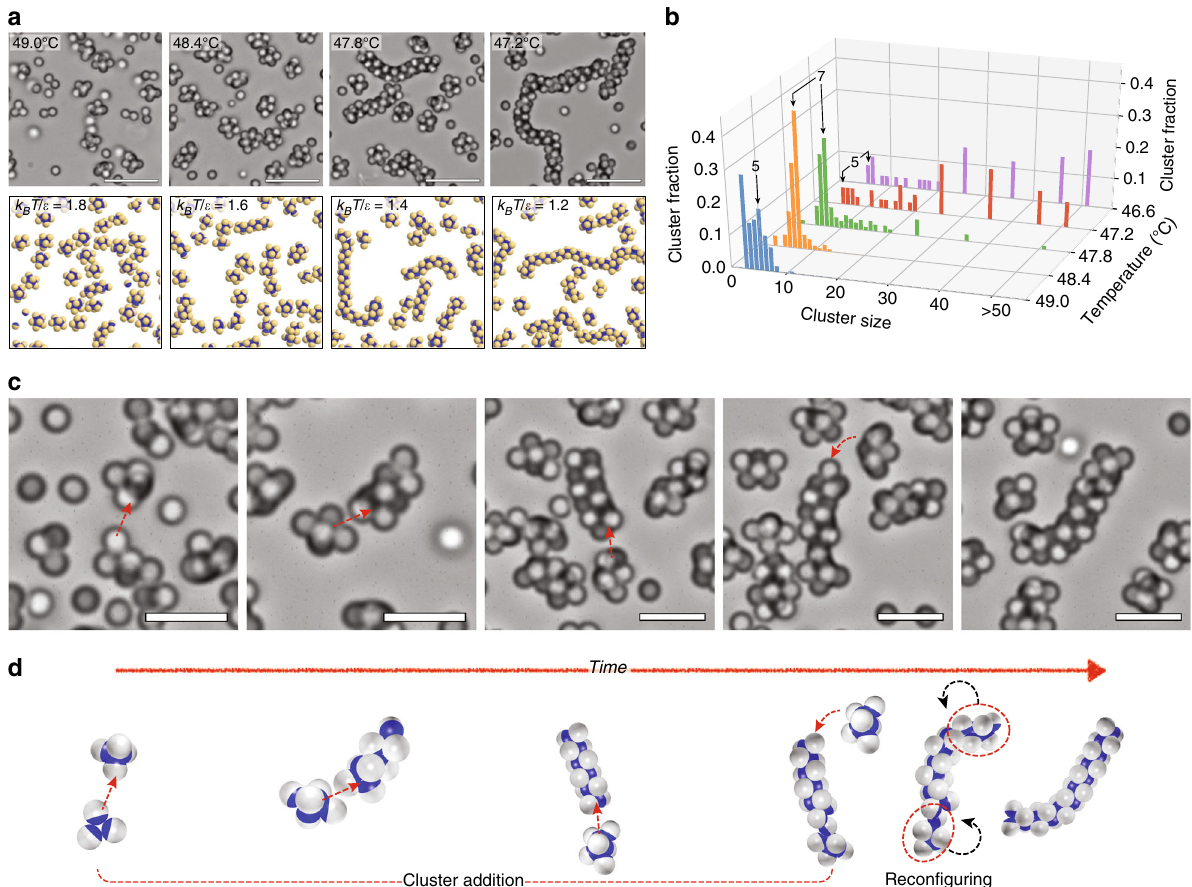
Fig. 3 Self-assembly of Janus particles to clusters and chains for a patch ratio of 0.3. a Bright- fi eld images above and simulation renderings below show self-assembled structures of Janus particles at different temperatures. Particles self-assemble into small clusters at higher temperature and longer chain- like structures at lower temperature, where the DNA-mediated attraction between patches is greater. b Fraction of clusters in clusters of different sizes as a function of temperature. At higher temperatures, small clusters with 8 or fewer particles dominate. As the temperature is lowered, chains develop and grow longer, mostly by the addition of small clusters but occasionally by fusion of long chains. For cluster sizes greater than 20, the histogram bars integrate over ten or more bins: 21 – 30, 31 – 40, 41 – 50, and >50. c Snapshots and d illustrations show the formation of chain structures by